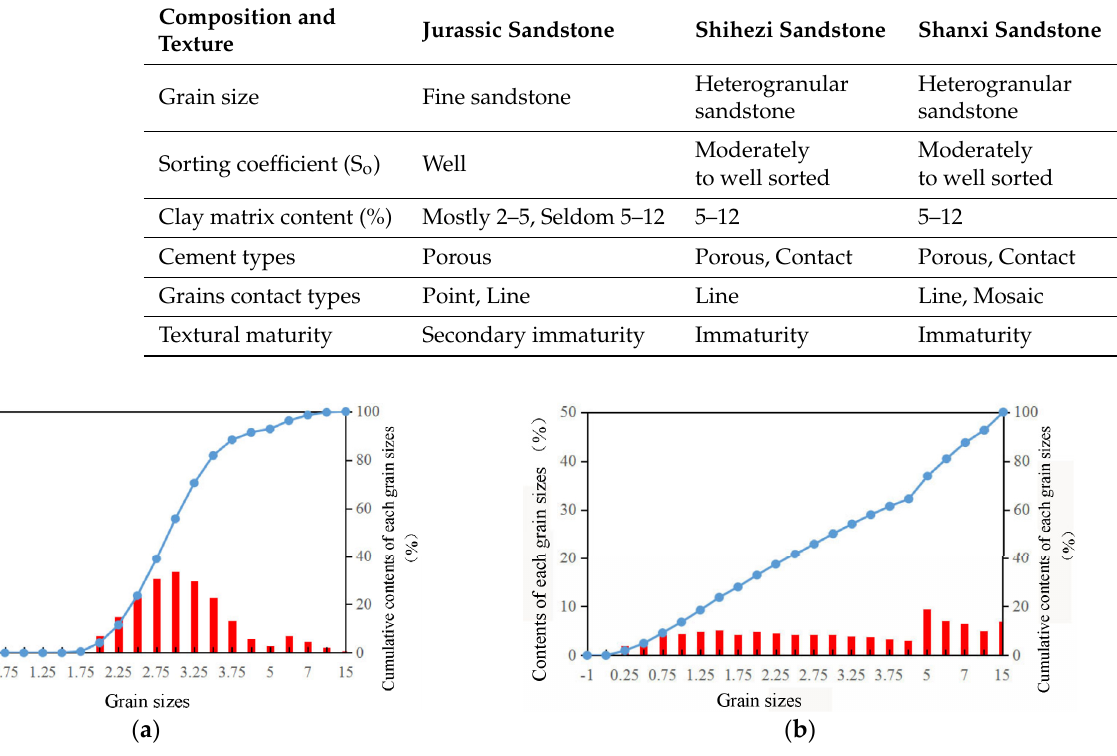
Figure 7. The distribution curves of the frequency and cumulative frequency of grain sizes: ( a ) The Jurassic sandstone has a single peak and nearly normal distribution in the grain size frequency curve (sample Z23). ( b ) The Permian Shanxi sandstone has a multipeak and nonconcentrated distribution in the grain size frequency curve (sample X9).